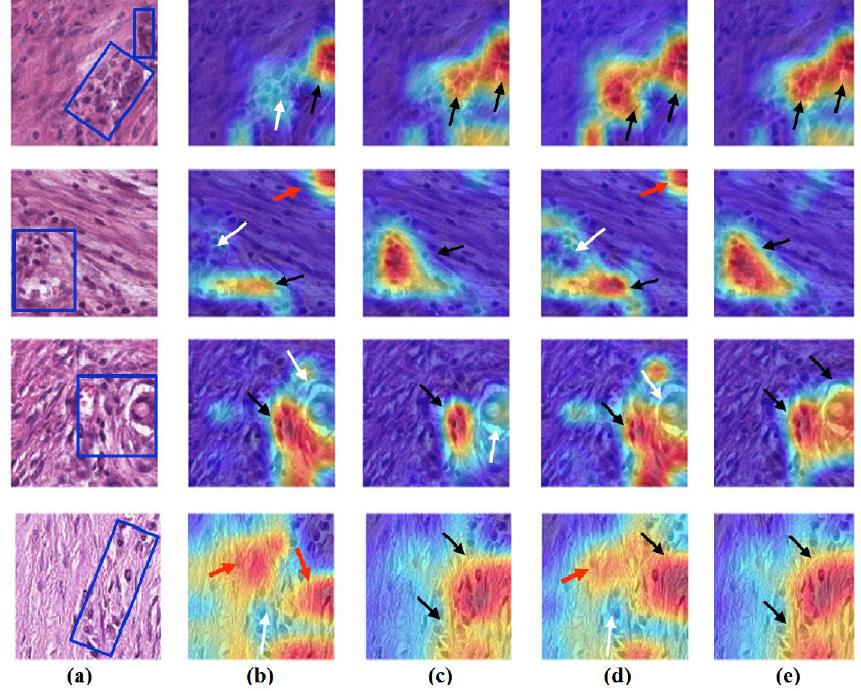
Figure 14. Visualisation of deep features for class STR of CRC test set images obtained by each model: